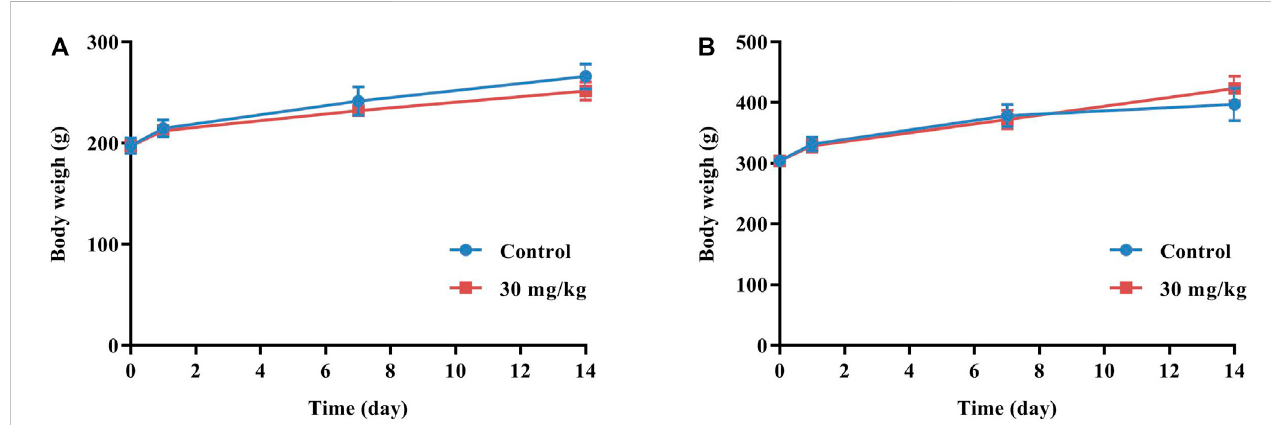
FIGURE 1 Mean body weights of female (A) and male (B) rats in acute toxicity study.